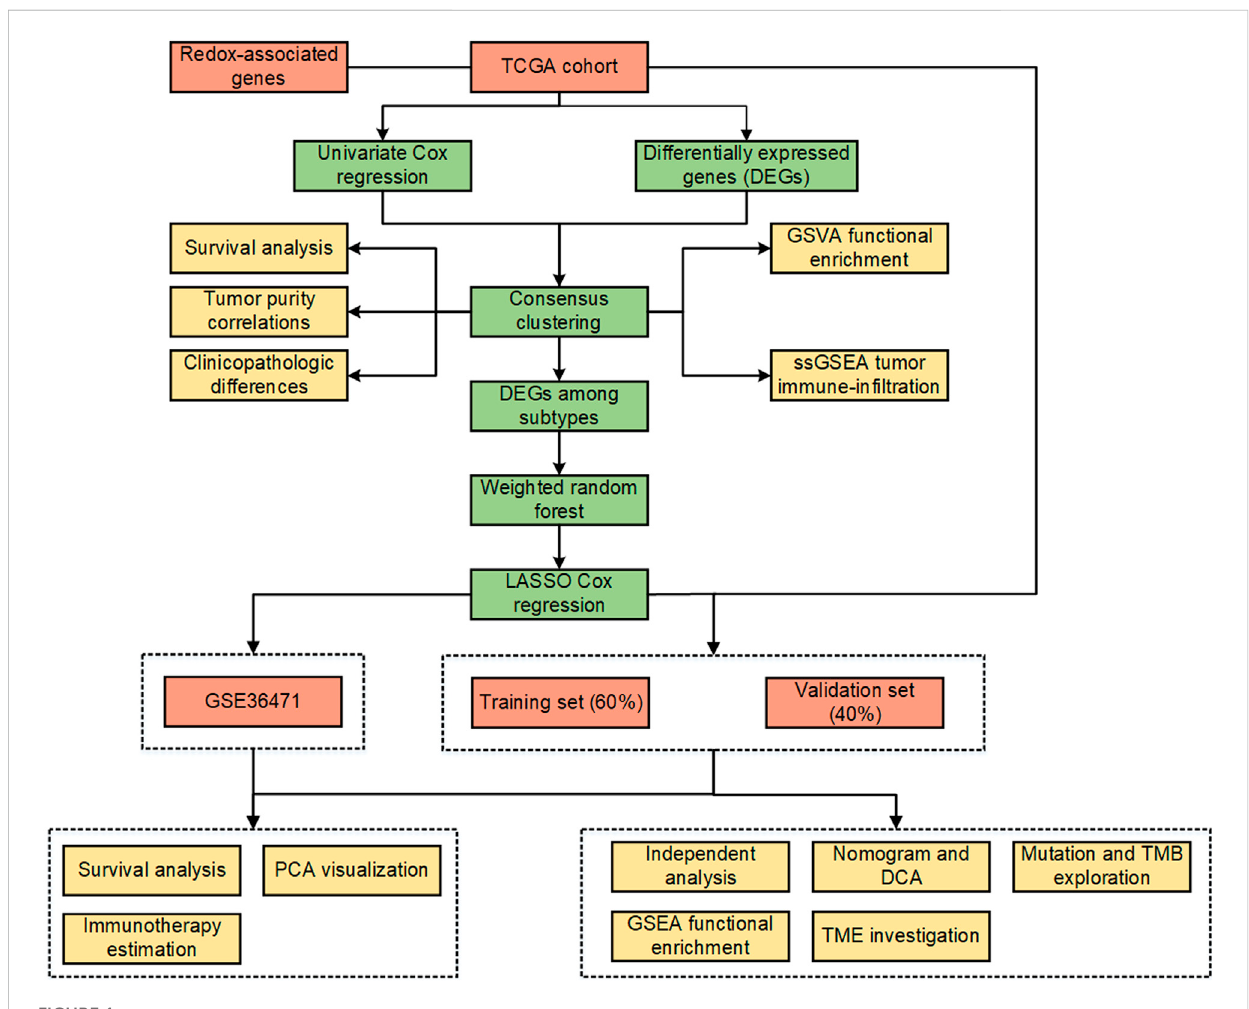
FIGURE 1 Work fl ow of the